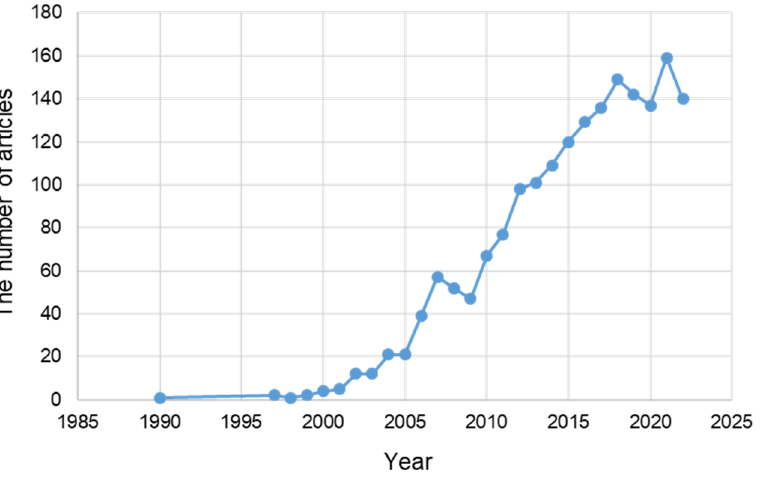
Figure 1. The number of articles related to ER stress among articles on neurodegenerative diseases published in PubMed from 1990 to 23 November 2022.